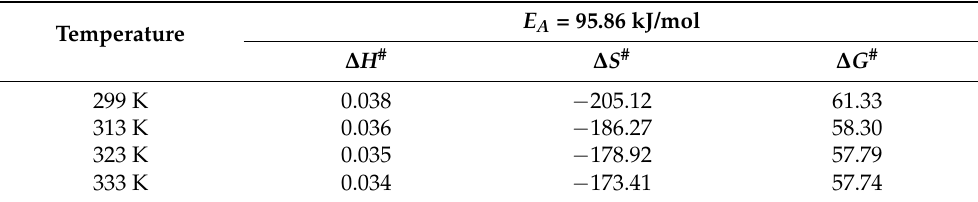
Table 5. Thermodynamic data for agricultural effluent oxidation using Montmorillonite-based photo- Fenton reaction *.